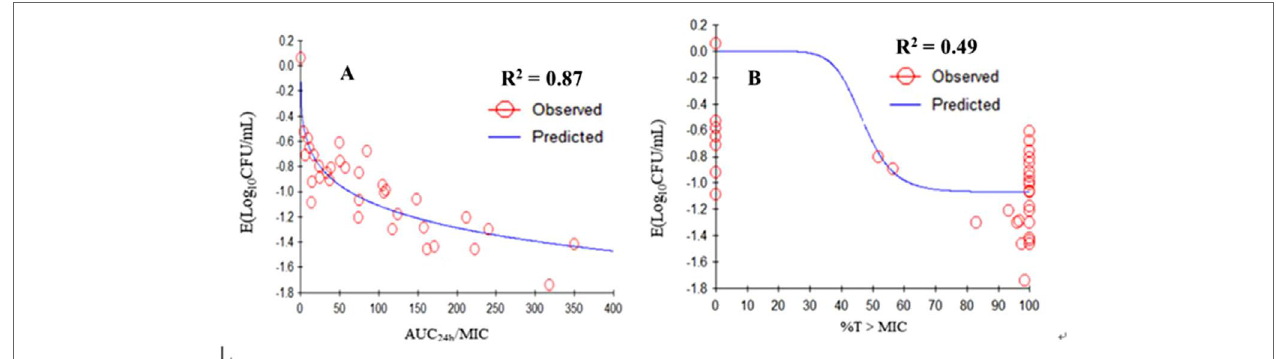
FIGURE 6 | E max relationships for the three PK/PD parameters versus the antimycoplasmal effect. A. AUC 0-24h /MIC-antimycoplasmal effect curve; B. %T > MIC- antimycoplasmal effect curve. R 2 is the correlation coefficient. E max , sigmoid maximum effect; PK, pharmacokinetic; PD, pharmacodynamic; AUC, area under the concentration-time curve; MIC, minimum inhibitory concentration; %T > MIC is the cumulative time that the concentration exceeds the MIC.